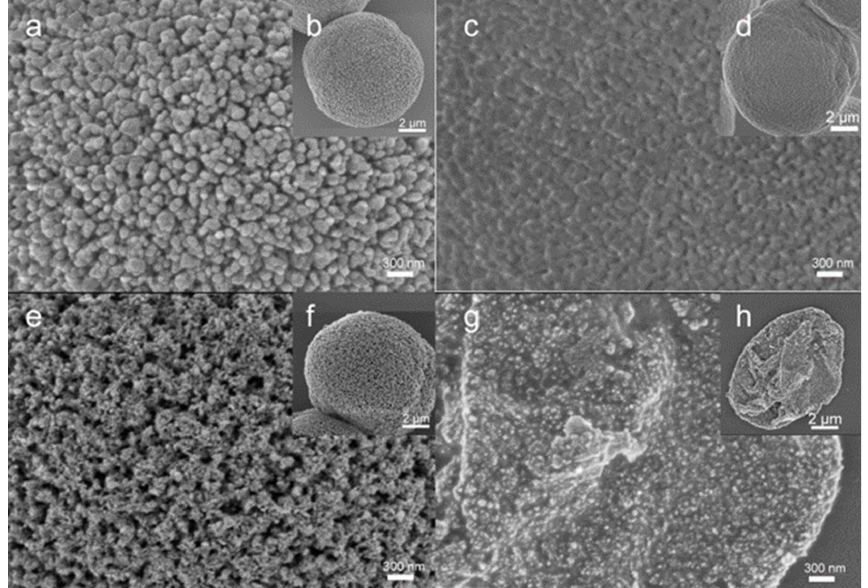
Figure 2. SEM images of: ( a , b ) CaCO 3 microcrystals; ( c , d ) –Au NPs/CaCO 3 hybridsobtained by Au NP adsorption (method 1); ( e , f ) Au NPs/CaCO 3 hybrids obtained by Au NP adsorption and further reduction of HAuCl 4 (method 3); ( g , h ) porous Au microshells obtained by method 3 followed by CaCO 3 template elimination with EDTA.